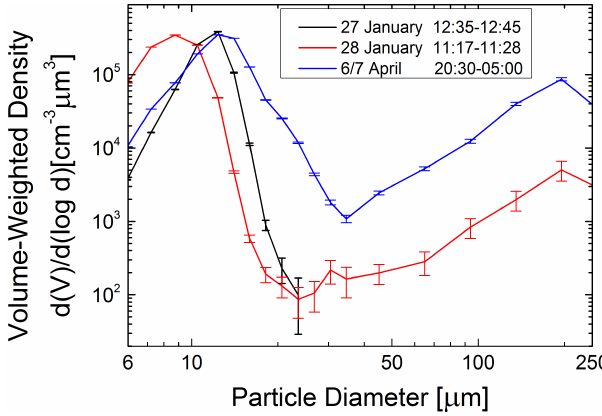
Fig. 8. Cloud-particle volume distributions measured by HOLIMOII during April 2012 at Jungfraujoch. The error bars are for one standard deviation, assuming Poisson counting